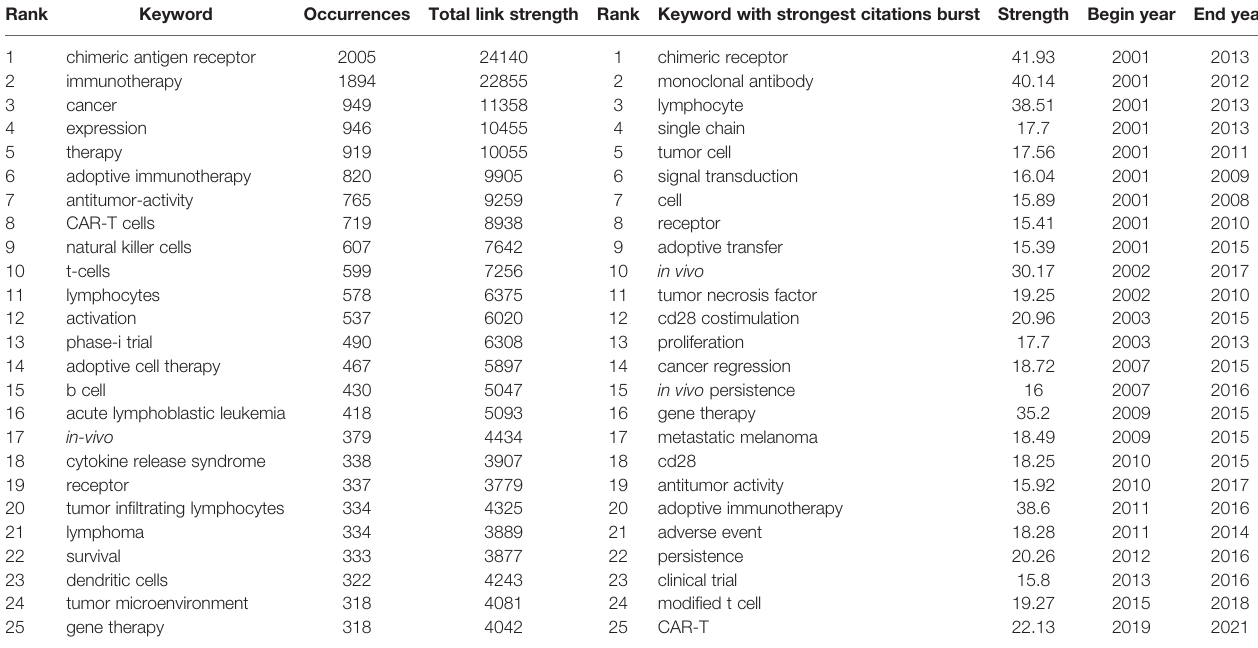
TABLE 5 | Top 25 co-occurrence keywords and top 25 keywords with strongest citations burst related to CAR-based immunotherapy. Rank